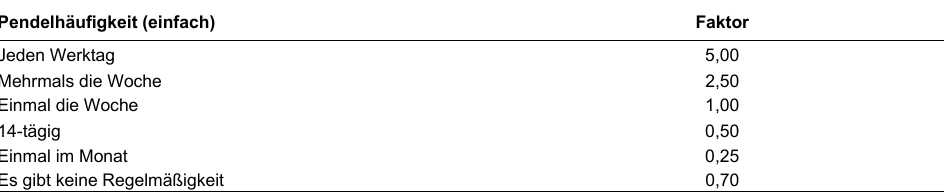
Tabelle 1 : Faktoren zur Berechnung des Wochenarbeitsweges Pendelhäufigkeit